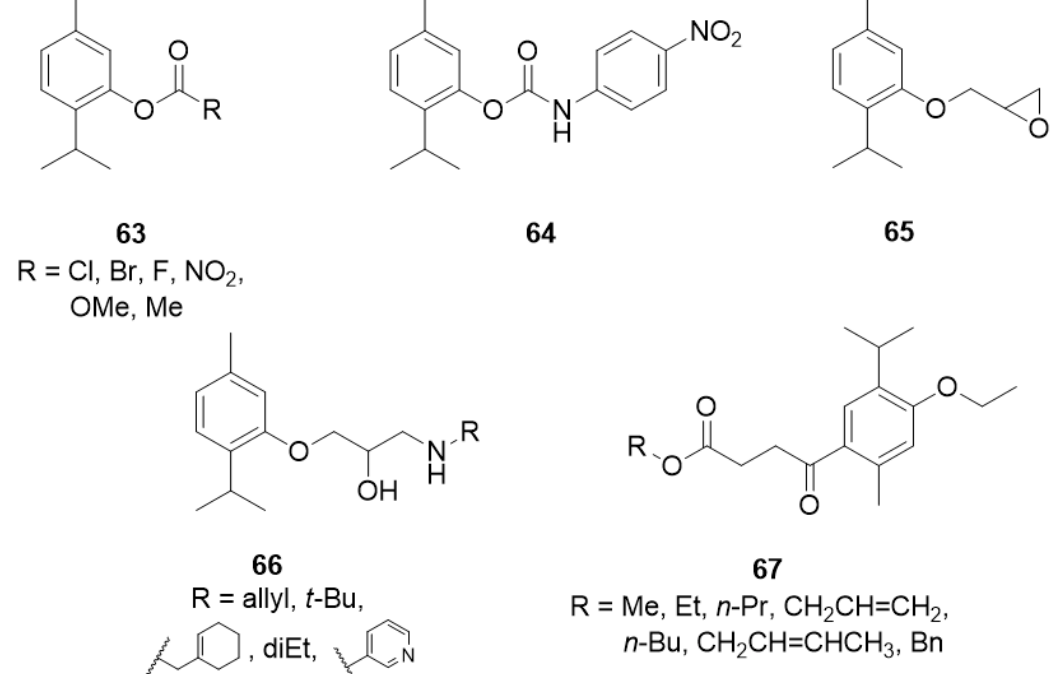
Figure 14. Thymol derivatives with inhibitory effects on some metabolic enzymes.